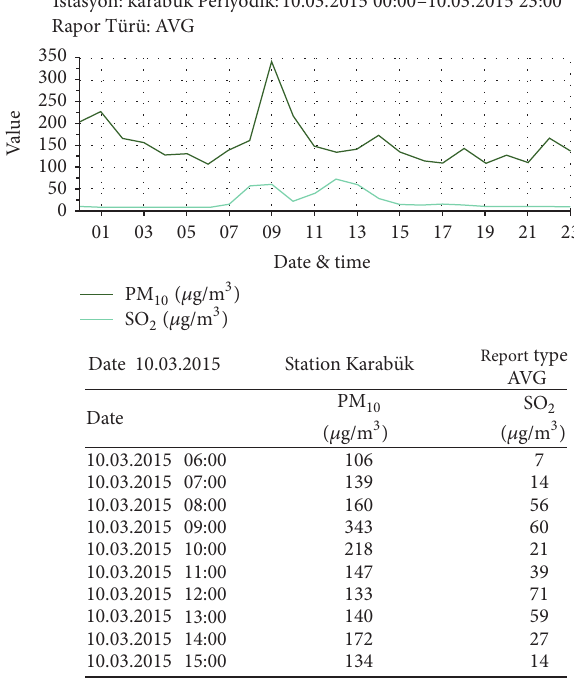
Figure 2: The amount of airborne PM 10 and SO 2 .